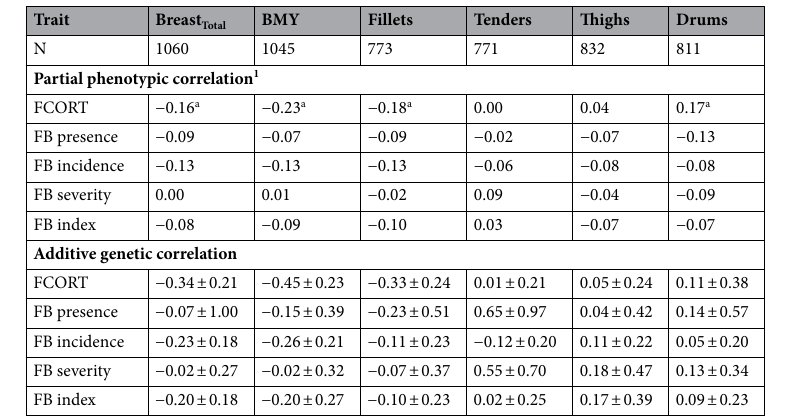
Table 3. Genetic and partial phenotypic correlations of feather corticosterone (FCORT) and fault bar (FB) traits with carcass traits in turkeys (N = 771–1060 depending on trait). Carcass traits include Breast Total (fillet + tender, kg), breast meat yield (BMY, %), fillet weight (kg), tender weight (kg), thigh weight (kg), and drum weight (kg). 1 Significant partial phenotypic correlations are denoted by letter superscripts where a = p < 0.05 and b = p < 0.0001.